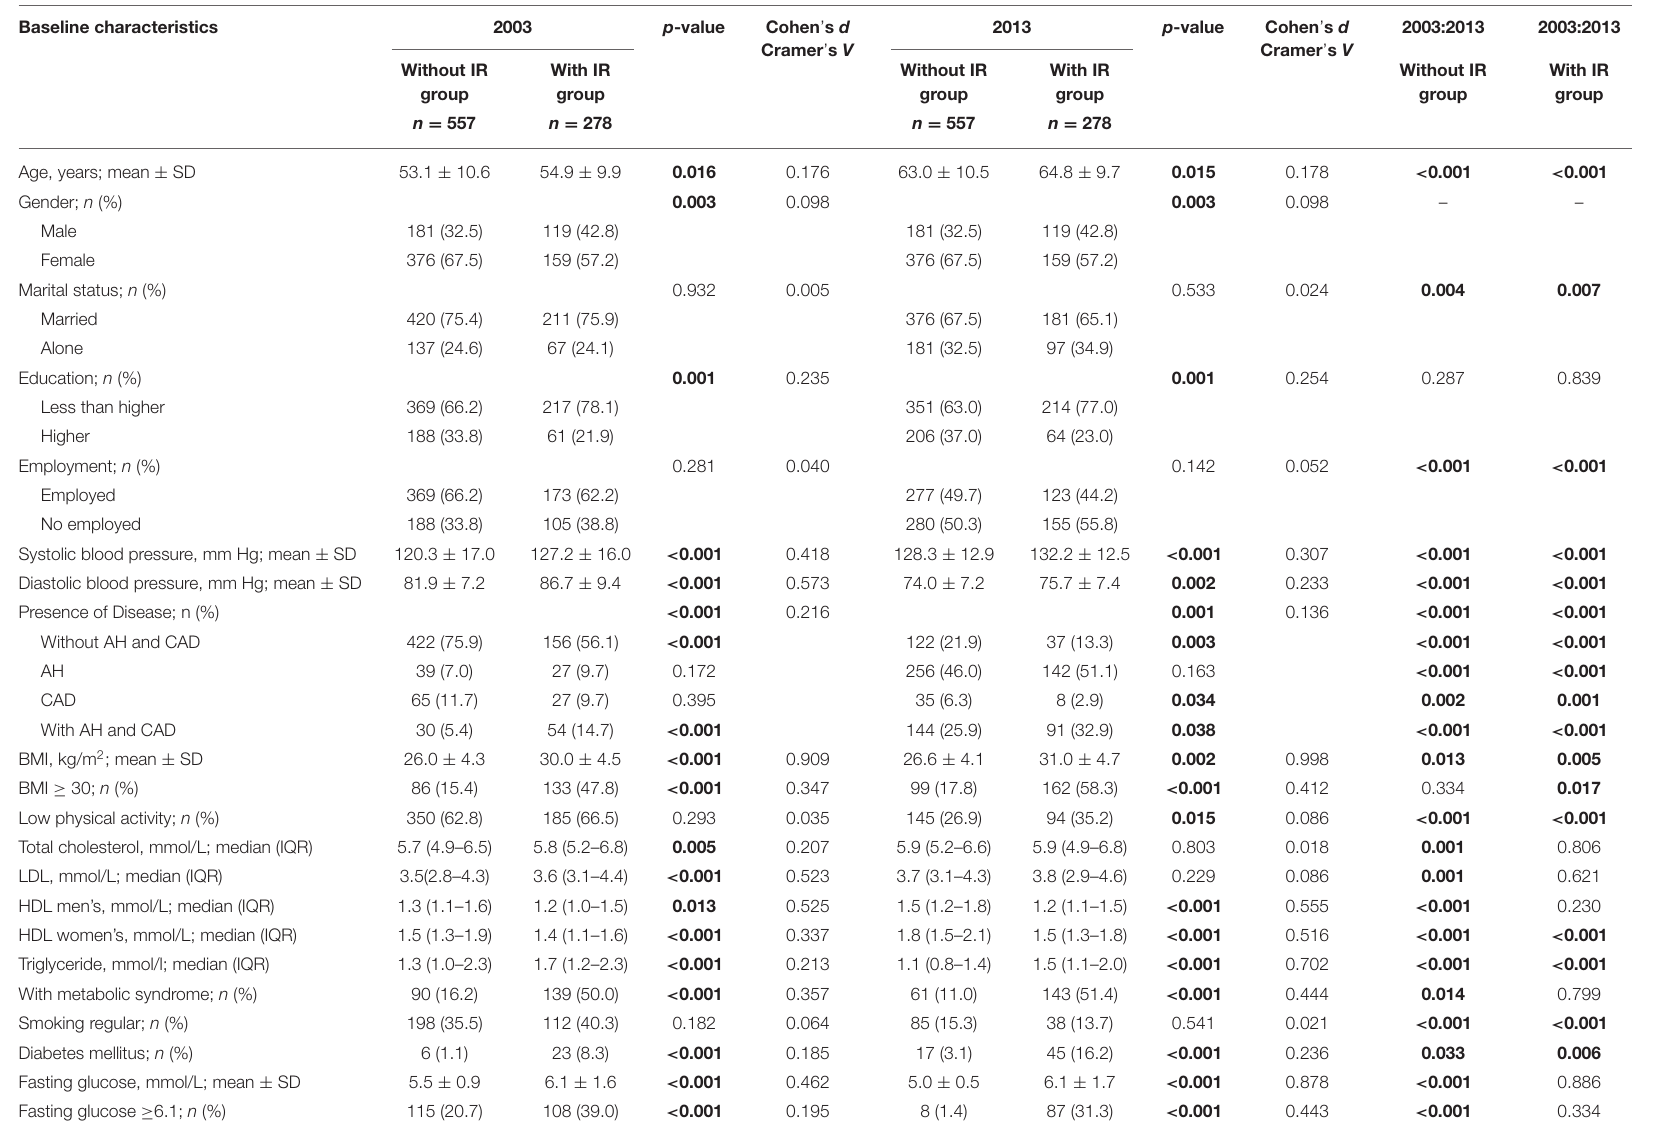
TABLE 1 | The sociodemographic and cardiovascular risk factors characteristics of subjects’ in the survey in 2003 and 2013 according to the presence of insulin resistance. Baseline